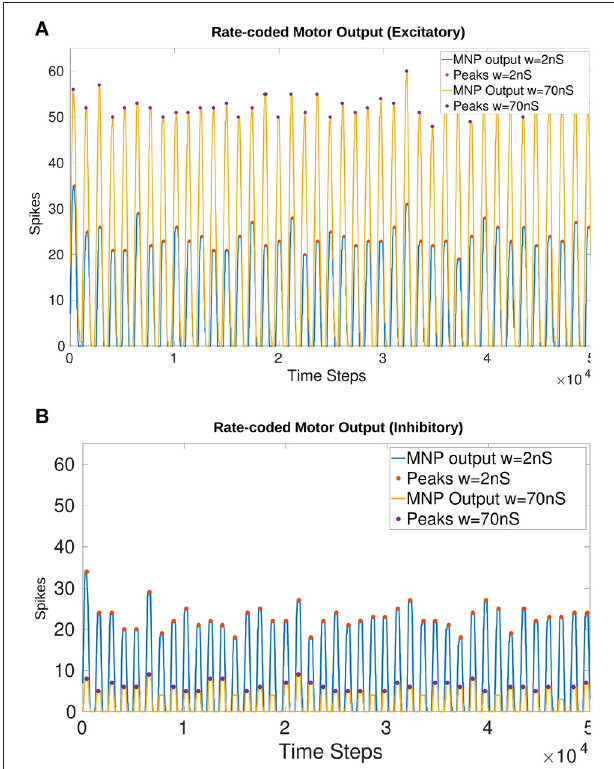
FIGURE 6 | Comparison of the output from the MNP when w in Equation (5) is 2 nS vs. 70 nS with a constant maximum I input of 148 pA into the NSI (Equation 3). There is a visible change in amplitude without affecting the frequency or phase. The peaks (local maxima) are marked with a filled circle. (A) Injects excitatory current to the MNP; (B) Injects inhibitory current to the MNP.